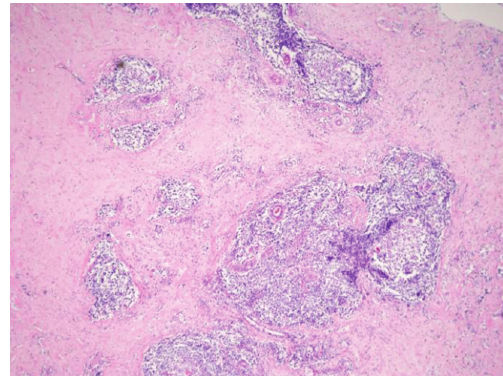
Figure 1: Three separate tumors of the breast by palpation and imaging, two hard tumors in the CDA and A areas of the right breast and one nonpalpable solid tumor in the C area of the left breast were found.